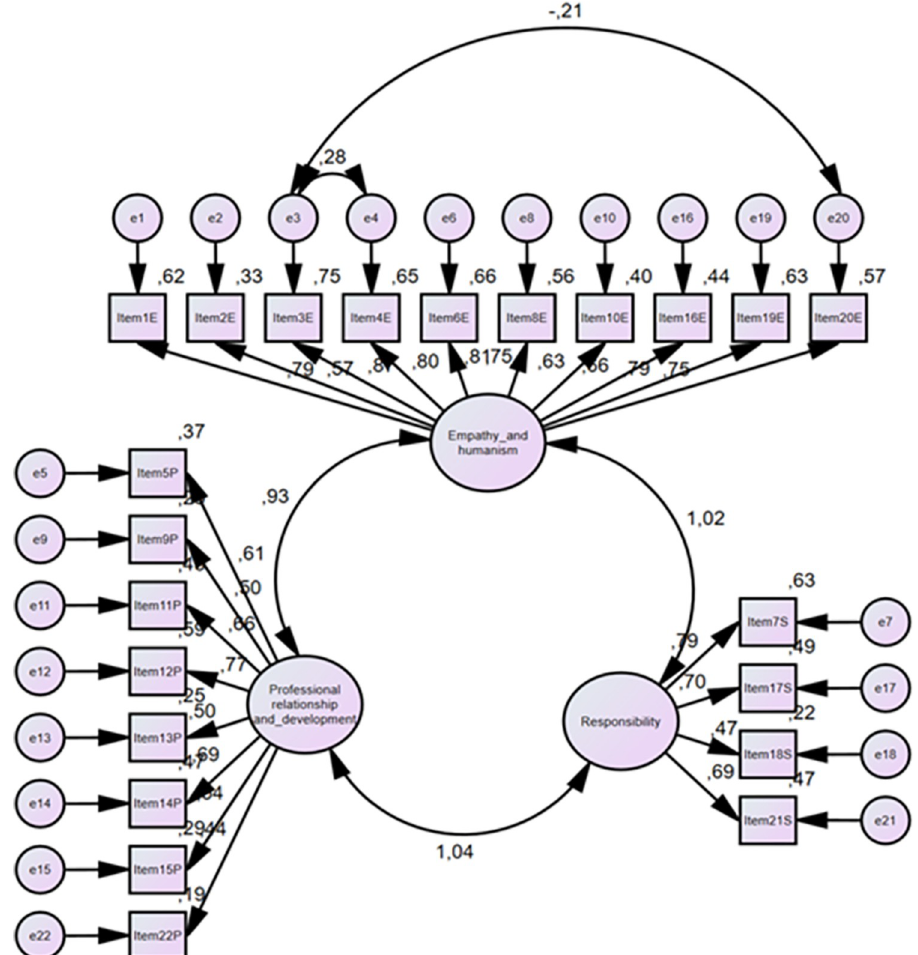
Fig 2. Confirmatory factor analysis.